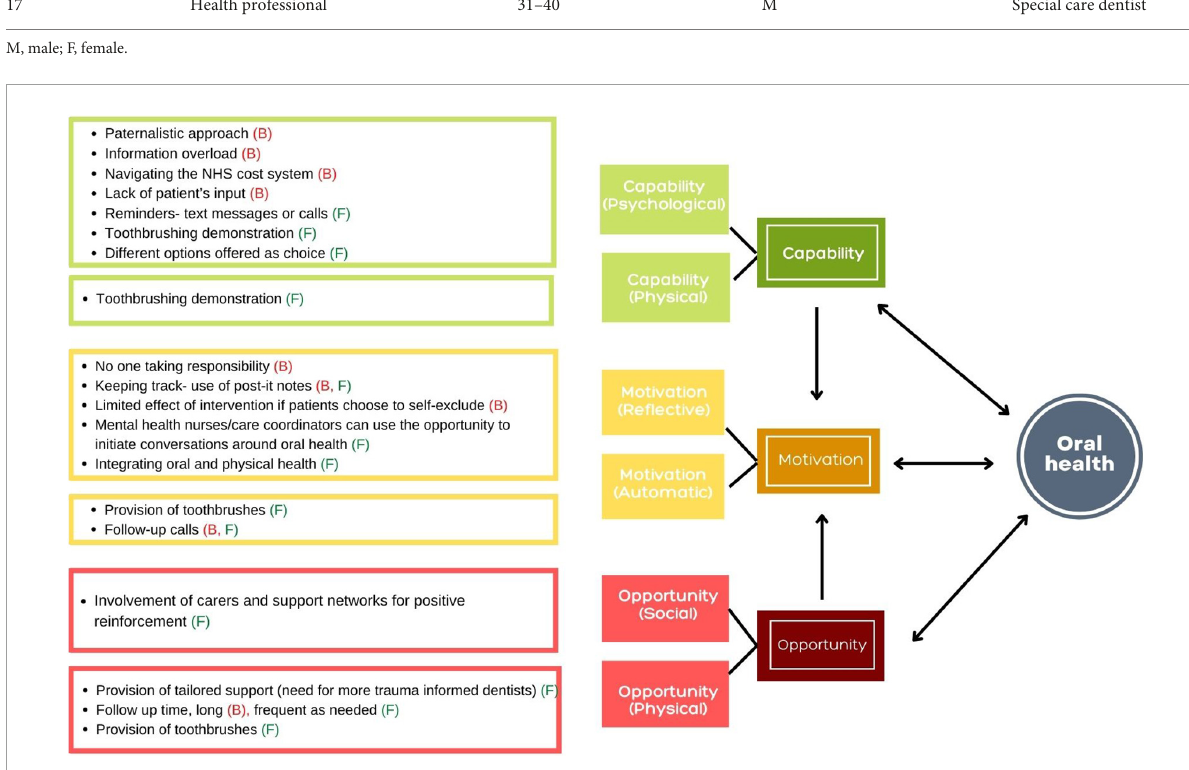
FIGURE1 The barriers (B) and facilitators (F) reported by the service users on three main themes according to the COM-B